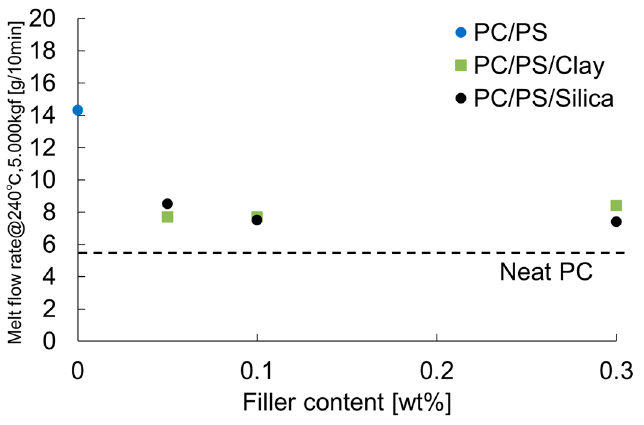
Figure 4. Melt flow rates of PC/PS/nano-filler composites.